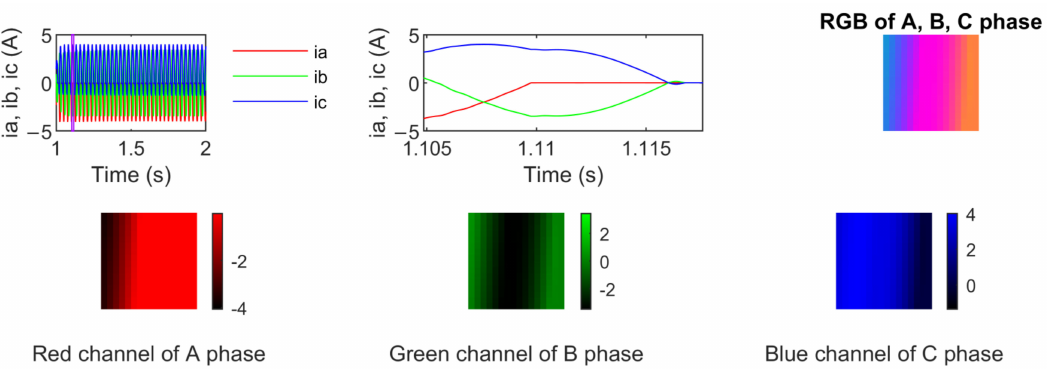
Figure 10. Transformation of the i a , i b , and i c currents into an RGB image for the fault of an upper switch in phase A of the 6S3P topology. The frame of the time window and its RGB image ( top ); each channel of the image ( bottom ).